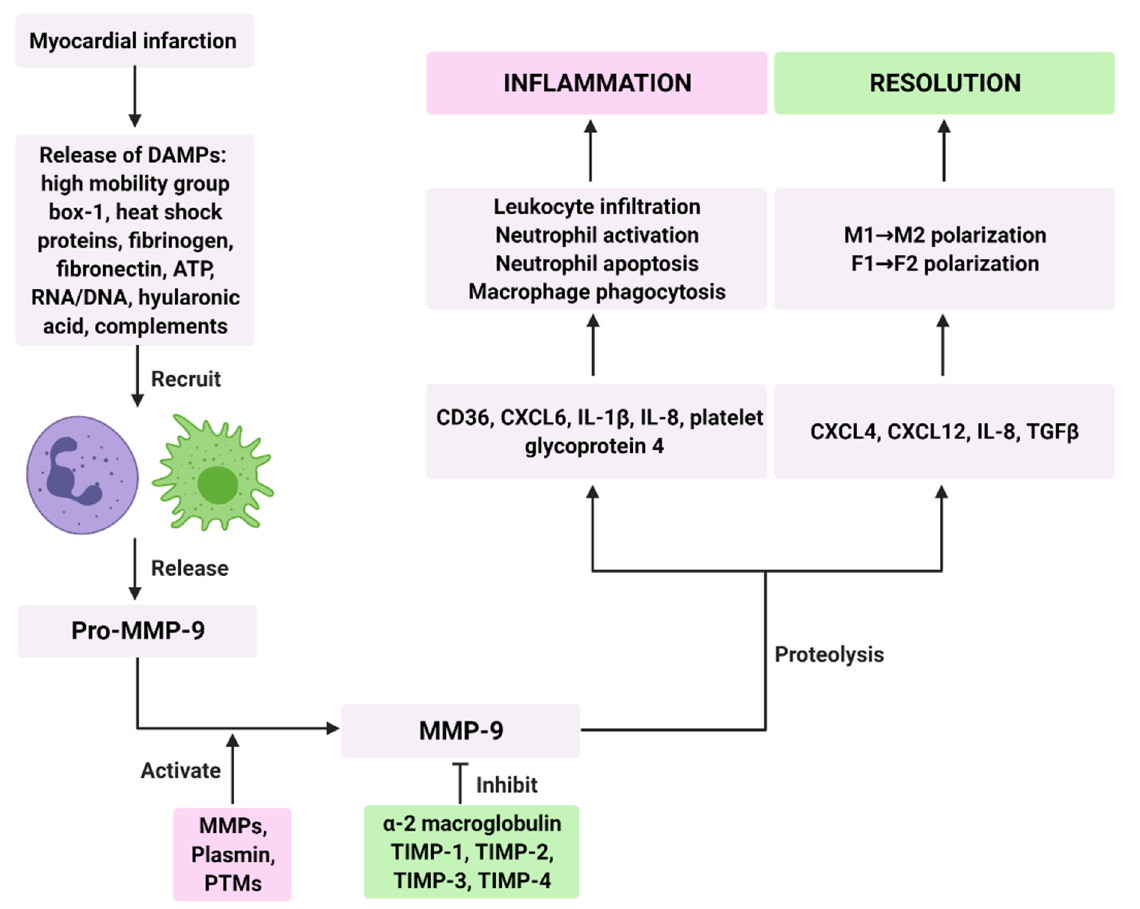
Figure 2. MMP-9 roles in inflammation and resolution after myocardial infarction. DAMPs: Danger associated molecular patterns, CD36: Cluster of differentiation 36, CXCL: CXC motif ligand, IL-1 β : Interleukin 1 beta, IL-8: Interleukin 8, MMP: Matrix metalloproteinase, PTM: Post-translational modification, TIMP: Tissue inhibitor of metalloproteinases, TGF β : Transforming growth factor beta. M1: Pro-inflammatory macrophages, M2: Anti-inflammatory/reparative macrophages, F1: Pro-inflammatory fibroblasts, F2: Anti-inflammatory/reparative fibroblasts. Created with BioRender.com (accessed on 23 March 2021) [85] .